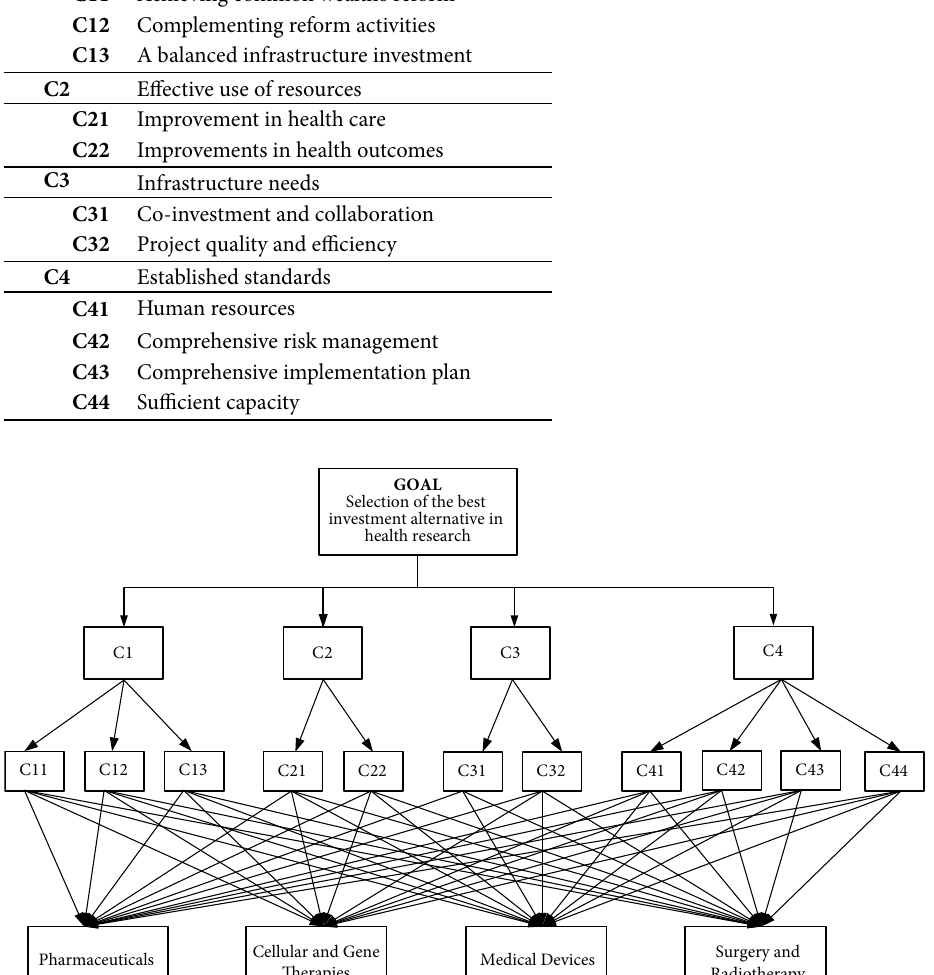
Fig. 2. The hierarchical structure for the best investment alternative in health